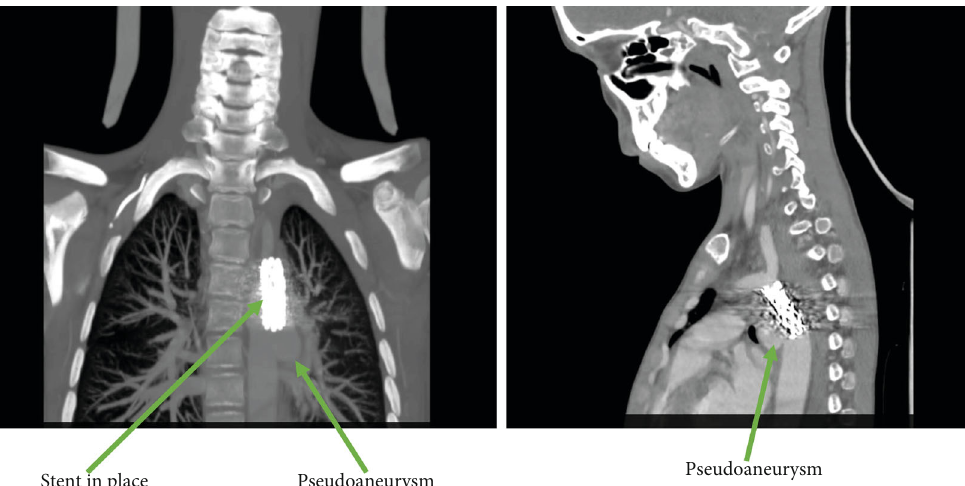
Figure 3: The thoracic angio-CT scan revealing a good opaci fi cation of the ascending aorta and the aortic arch with stent in place, with two sacciform pseudoaneurysms in the descending aorta just below the stent.